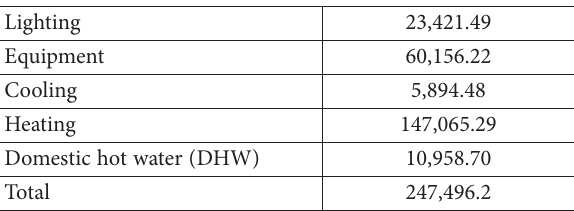
Table 5. Final energy consumption by type of building